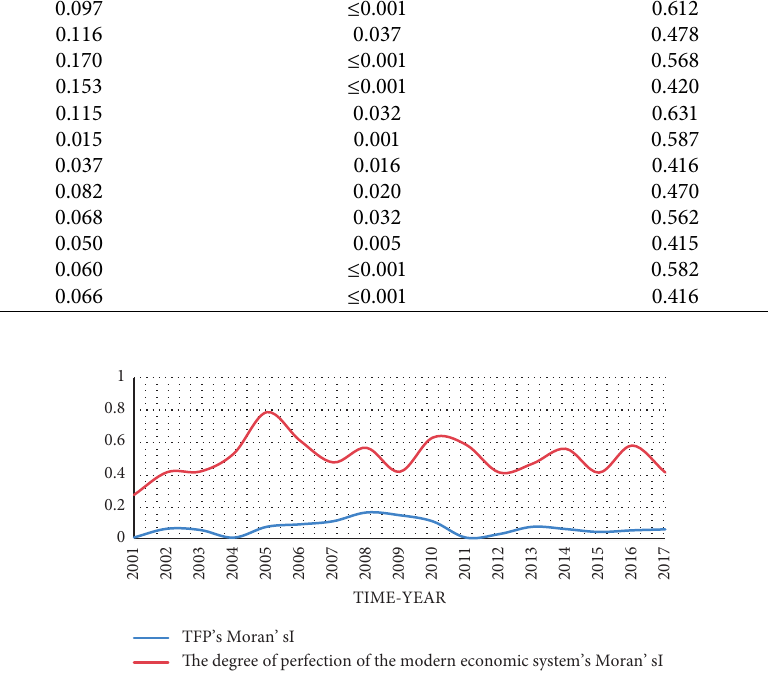
Figure 3: 2007–2017 Moran index of total factor productivity and modern economic